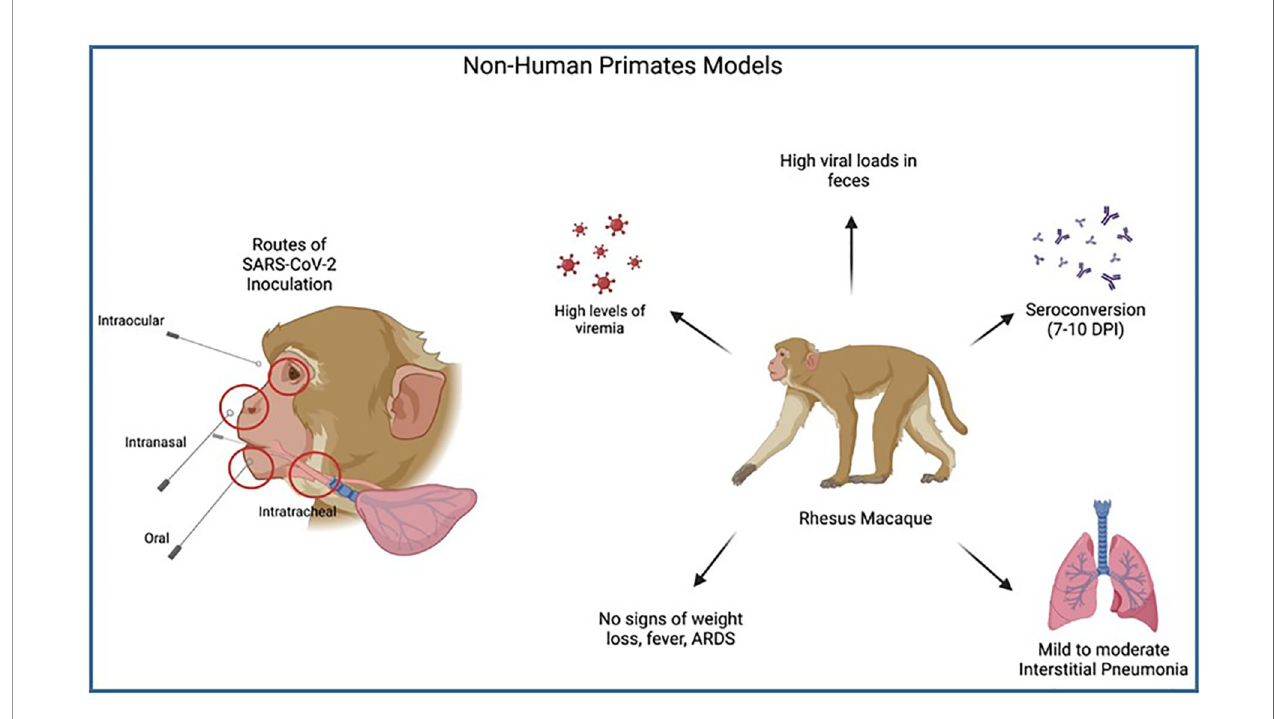
FIGURE 9 | Illustrates the process of Non-Human Primate model SARS-CoV-2 inoculation and clinical symptoms post-infection. Multiple routes of SARS-CoV-2 inoculation allow researchers to understand which area of the upper airways are most susceptible to SARS-CoV-2 infection, with the highest levels found in the pharynx and nasal cavities. A common NHP model, Rhesus macaques, have been shown to have high levels of viremia & viral loads in feces, with seroconversion comparable to humans and mild clinical symptoms (mild-moderate interstitial pneumonia). No systemic symptoms or ARDS were seen in infected macaques making this model less useful in studying severe